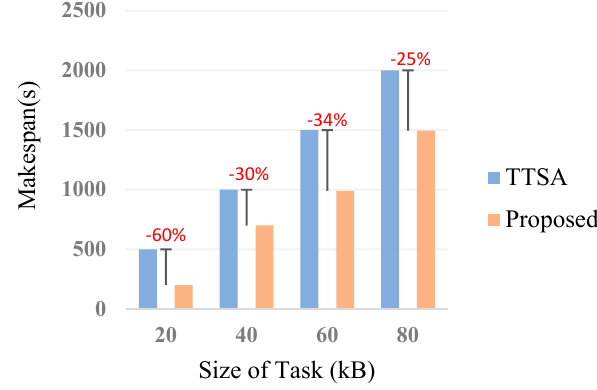
Figure 6. Comparison of makespan.